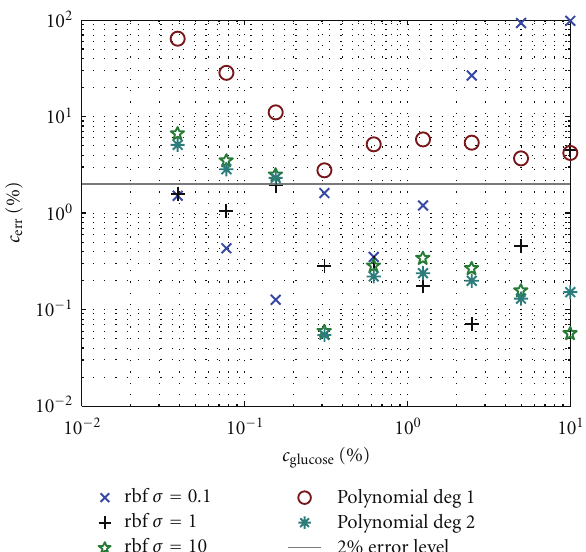
Figure 12: Statistical evaluation using k-fold cross validation for nominal wavelength ( Δ λ = 0nm), showing the e ff ect of temper- ature variation.